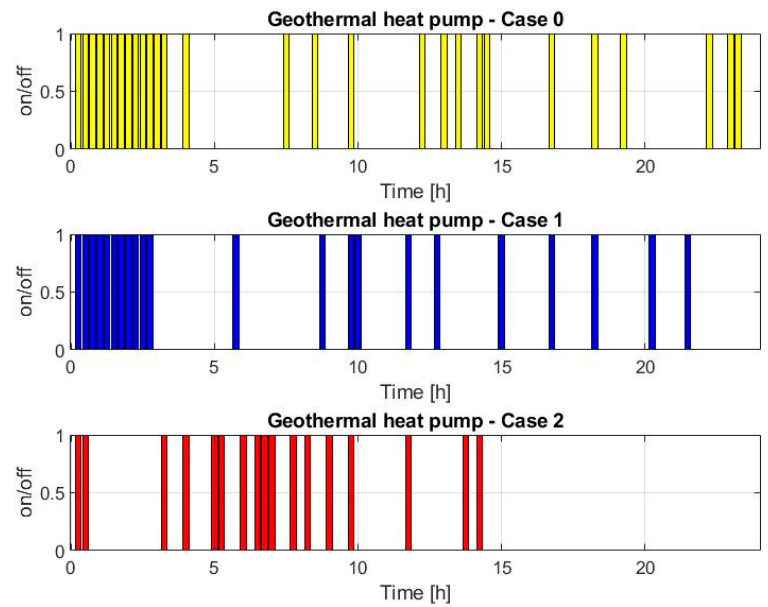
Figure 20. Geothermal heat pump operation scheduling, in the three different cases.